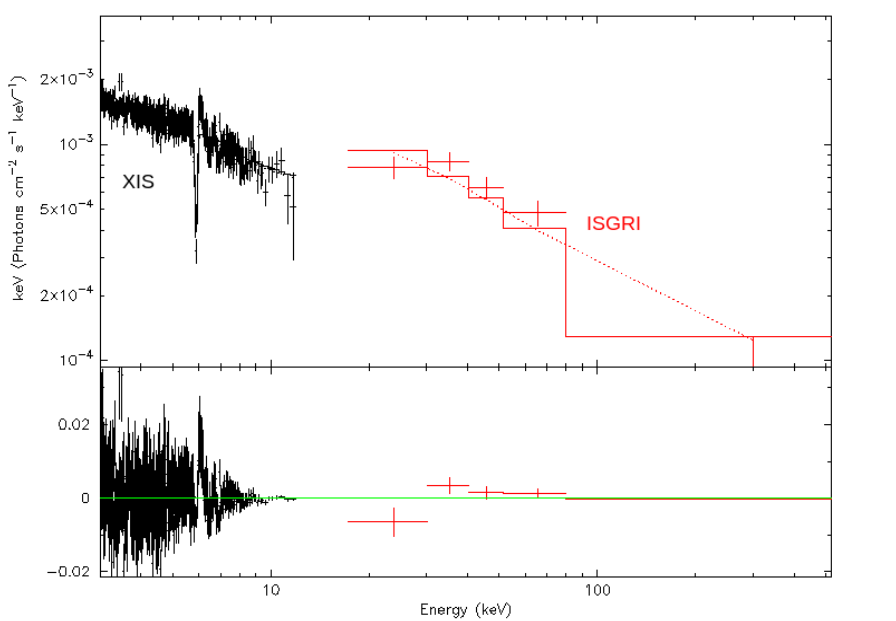
Figure A3. Unfolded Suzaku/XIS and INTEGRAL/ISGRI spectra of 3C 111 during 3rd observational period (August 2008) and model. Above: all the spectra are shown by crosses; fitting curves are shown by solid lines; model components are shown by dotted lines; below: data residuals. This period is remarkable as during it in the spectrum of 3C 111 was clearly visible primary nuclear component only. Fe-K α line was bright and clearly distinguishable despite the presence of absorption line near 5.9 keV.